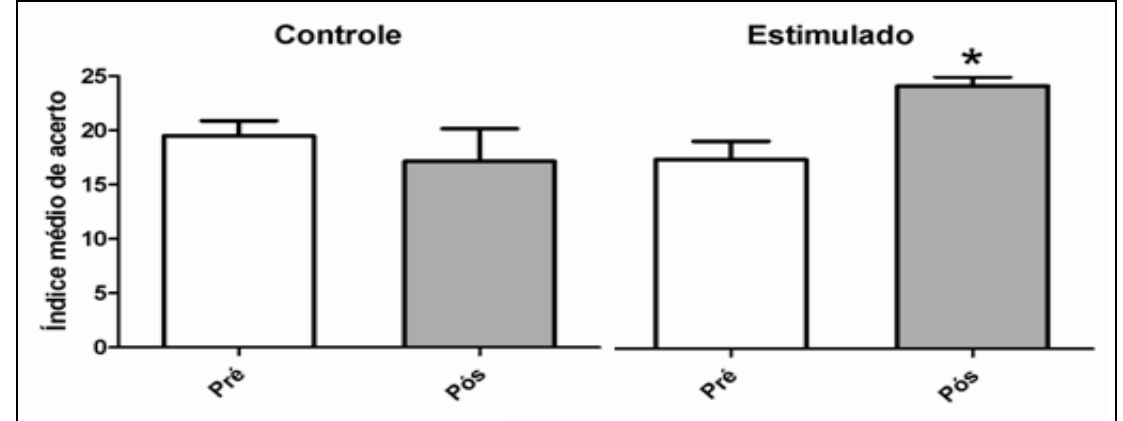
Figura 3. Performance média de acerto. Índice adquirido levanta em consideração acerto e erros nos quadrantes. Verifica-se o índice do grupo controle (esquerda) e estimulado (direito) nos momentos pré e após o treinamento. (*) Indica diferença após o treinamento com estimulação, p<0.05. Dados expostos